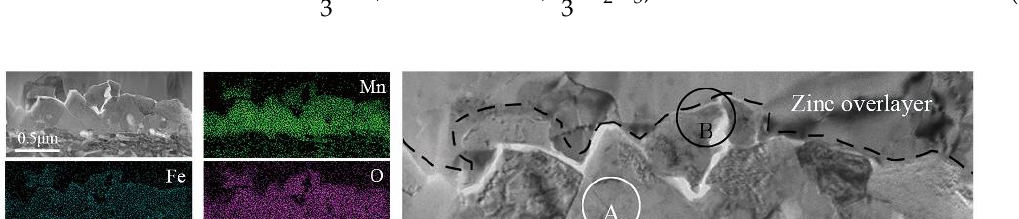
Figure 6. ( a ) STEM cross-sectional elemental maps of the coating/substrate interface and subsurface of the galvanized 10Mn steel annealed under the 243 K ( − 30 °C) DP process atmosphere. ( b ) TEM micrograph of the area shown in ( a ). ( c ) Dark filed image and diffraction pattern of the inhibition layer corresponding to zone A in ( b ). ( d ) Enlargement of the area corresponding to zone B in ( b ). ( e ) Detailed lattice information of MnO, xMnO·Al 2 O 3 , and Fe corresponding to circle regions in ( d ).